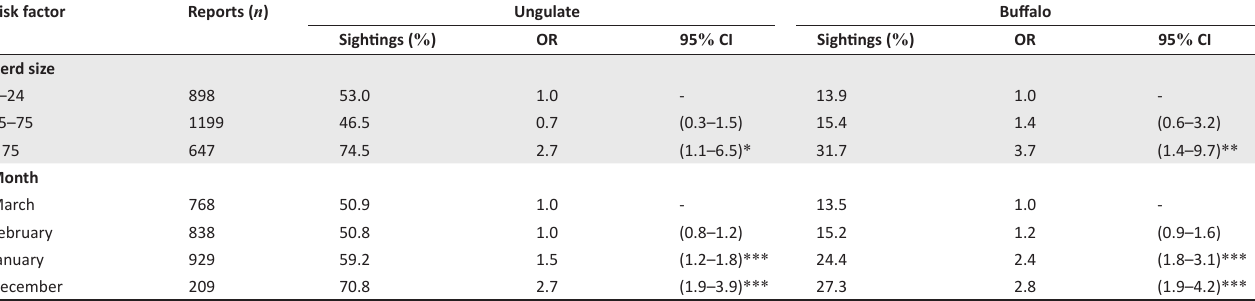
TABLE 5: Risk factors associated with sightings of ungulates and buffalo reporting odds ratios for univariate mixed models with farmer as a random effect. Risk factor Reports ( n ) Ungulate